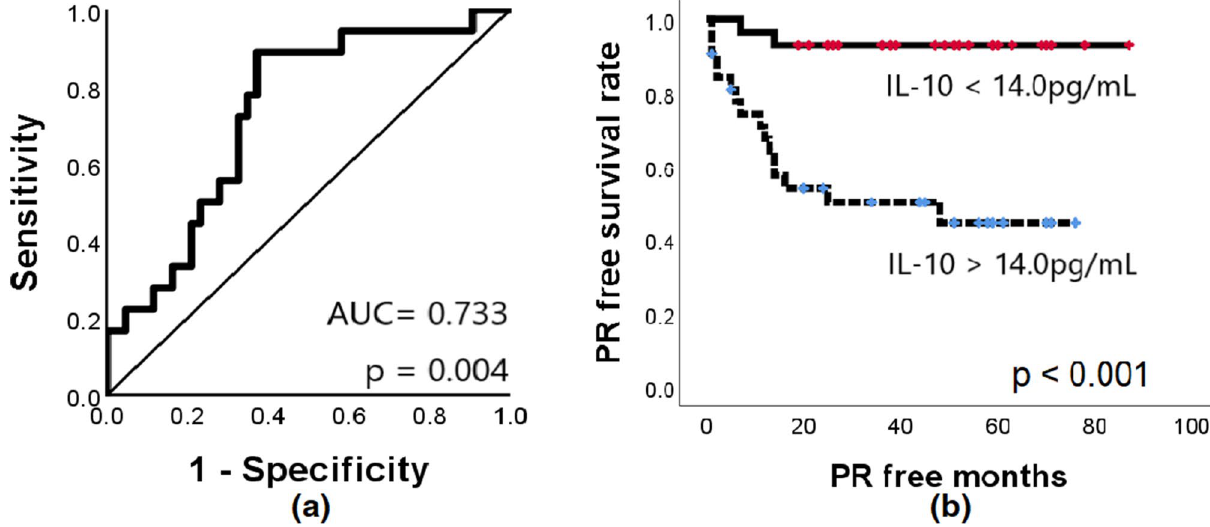
Figure 4. Ascitic IL10 level as a prognostic marker for peritoneal recurrence in patients with stage pT4 CRC. ( a ) Receiver operating characteristic curve for IL10 shows an AUC of 0.733 (p = 0.004). The relevant cut-off value is 14.0 pg/mL. ( b ) Peritoneal recurrence-free survival of patients with low (≤ 14.0 pg/mL) and high (> 14.0 pg/mL) peritoneal IL10 levels was significantly different ( p < 0.001; log-rank test). AUC area under the curve, PR peritoneal